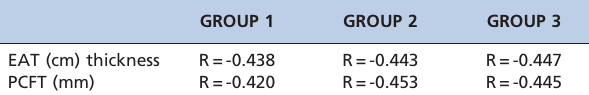
Table 3 - EAT and PCFT measurement correlation